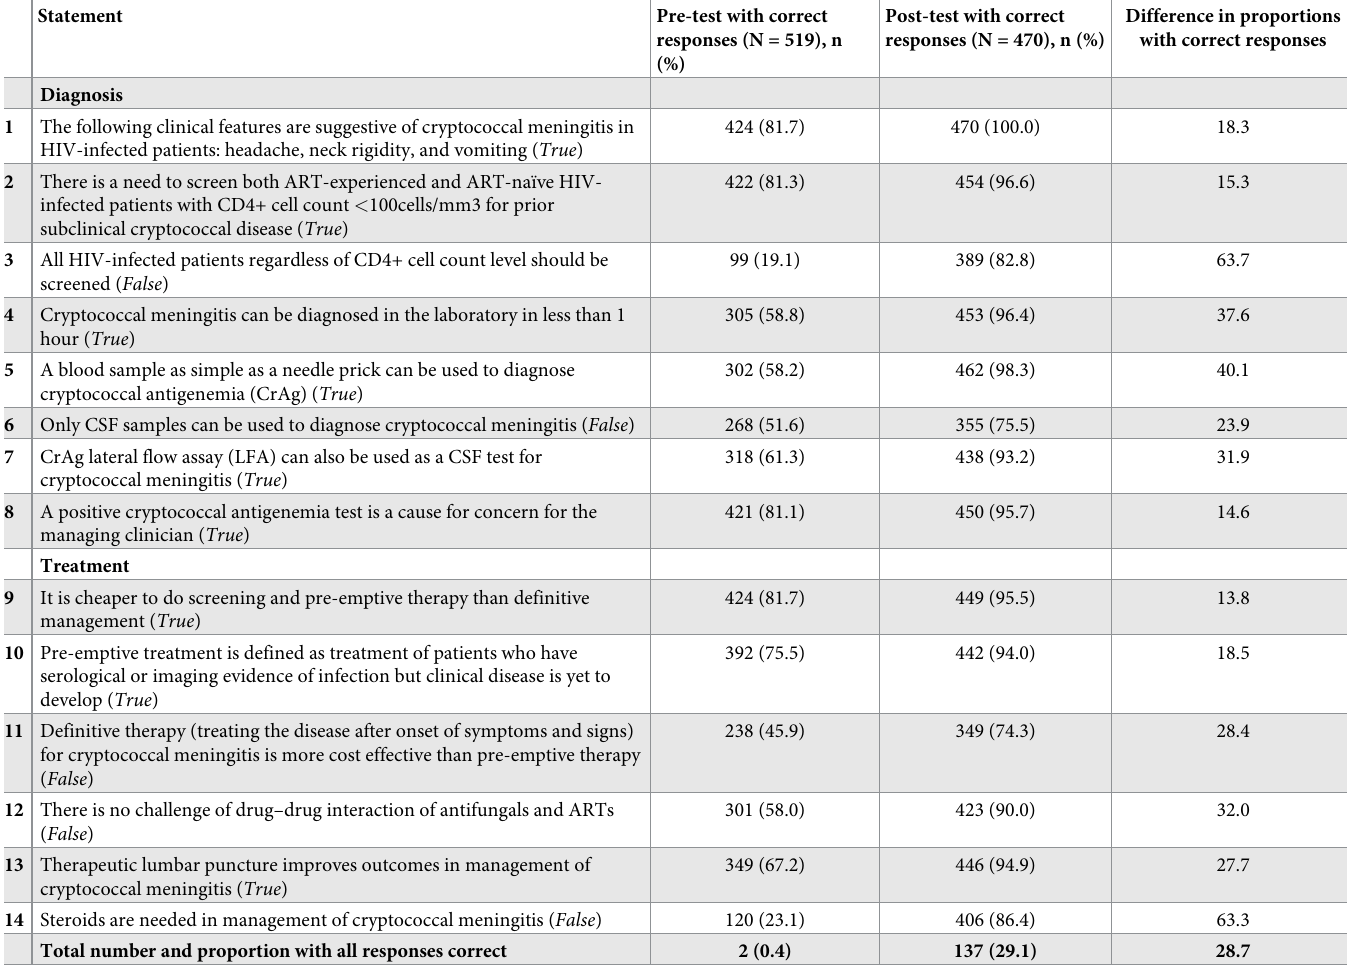
Table 1. Number and proportion of participants with correct